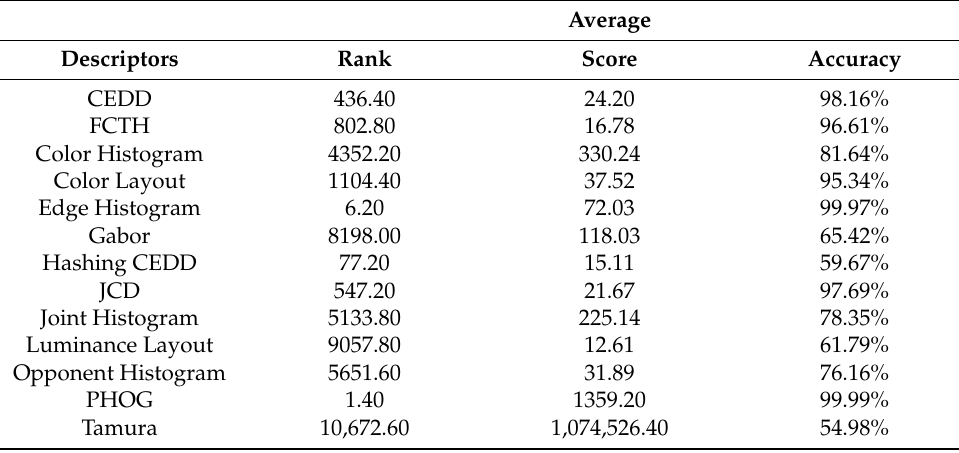
Table 8. Descriptors’ performance for retrieving glow-affected face